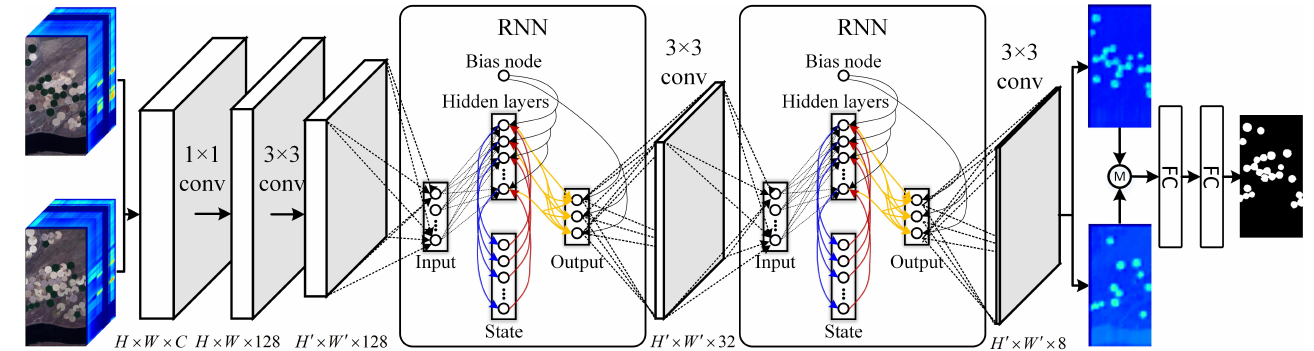
Figure 1. Architecture of our proposed method, which contains three main parts: the convolutional neural network part, recurrent neural network part and the final, fully connected layer